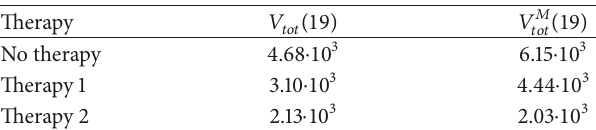
Table 4: Simulated and measured average total volumes on day 19 (mm 3